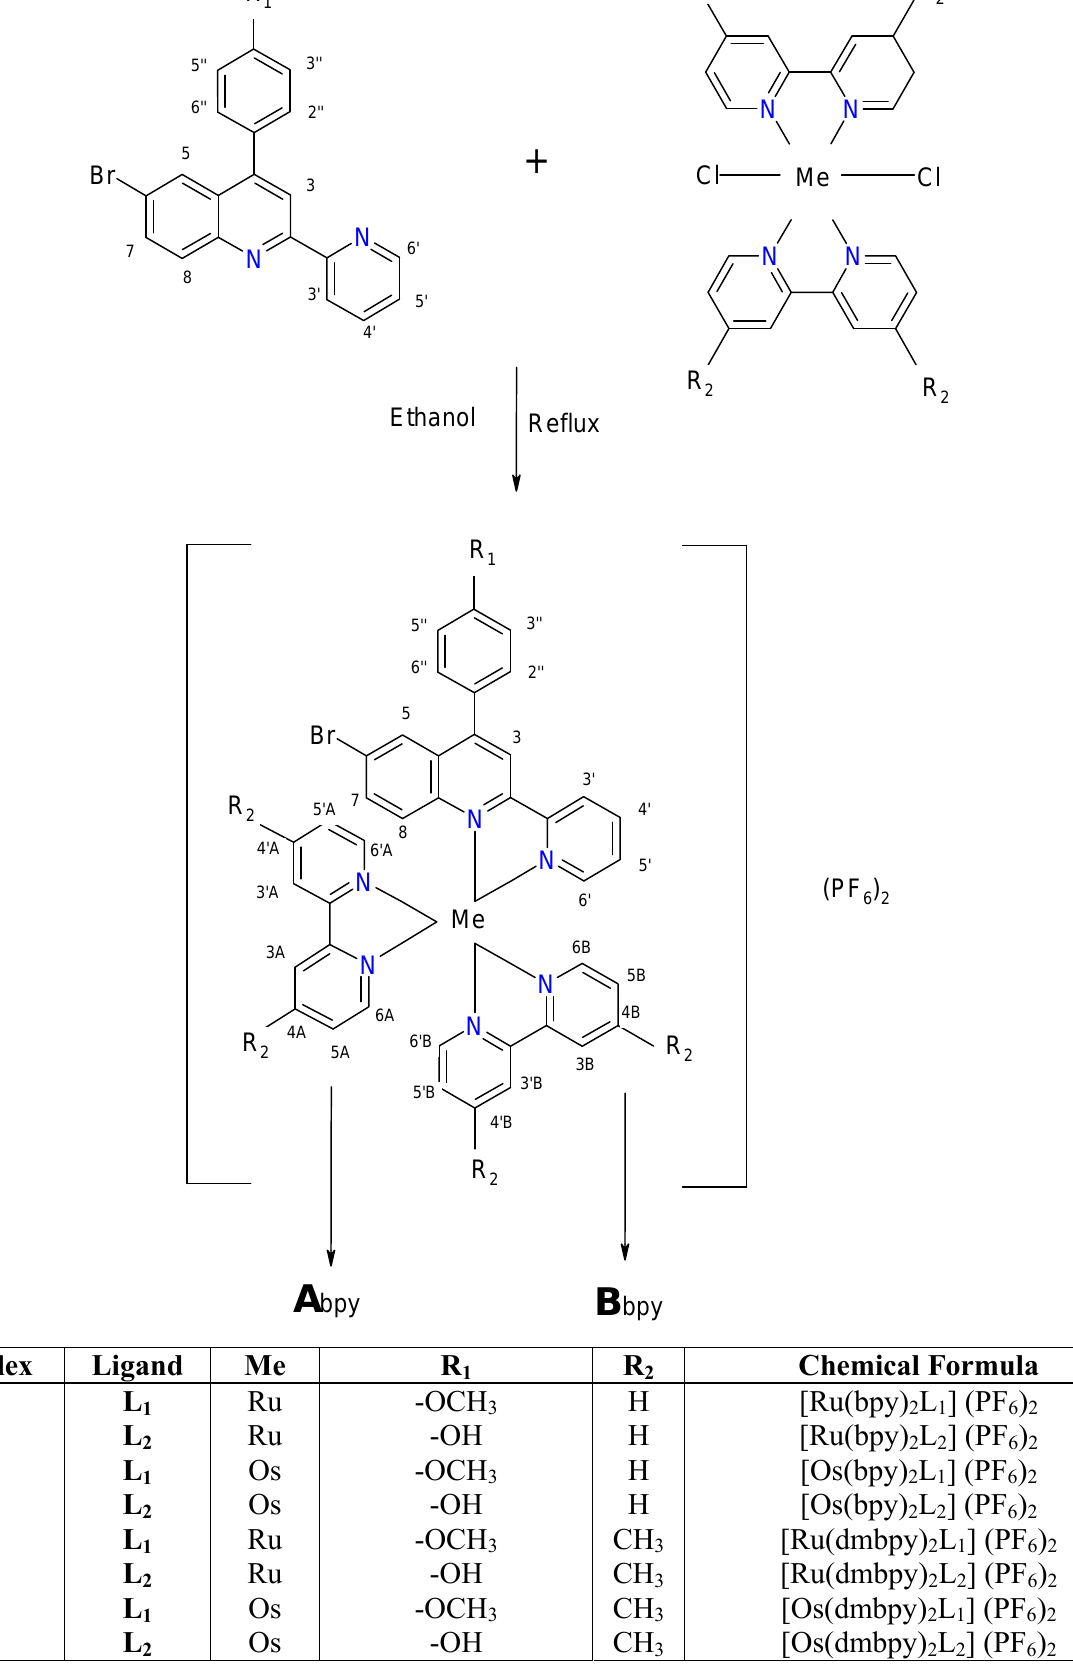
Scheme 4. Synthesis of complexes C